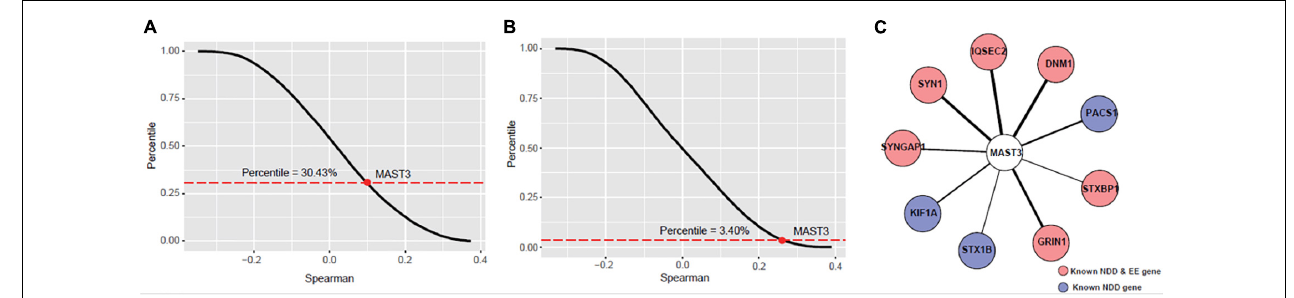
FIGURE 4 | Co-expression analyses of microtubule associated serine/threonine kinase 3 (MAST3) with EE and NDD genes. (A,B) The percentile of average correlation coefficient for all developing cortex expressed genes with NDD (A) or EE (B) genes. The average percentile of MAST3 was marked. (C) Interaction network contains nine highly co-expressed EE/NDD genes (Spearman’s correlation coefficient > 0.7) with